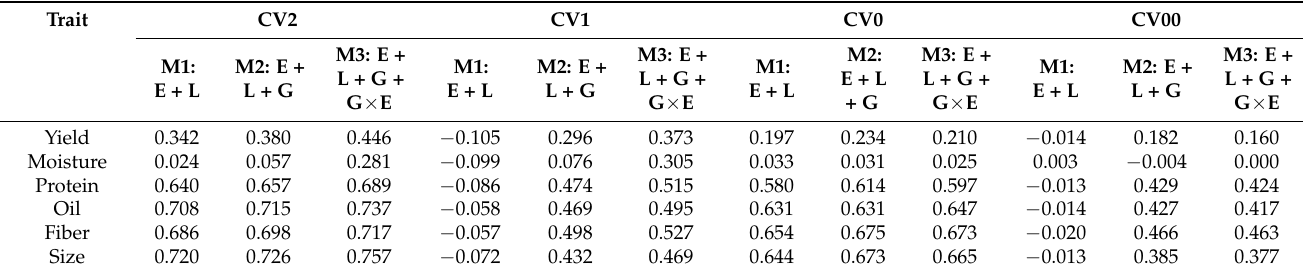
Table 4. Average mean (10 replicates) correlation between predicted and observed values for four cross-validation scenarios, three models (M1: E + L, M2: E + L + G, and M3: E + L + G + G × E) and 6 traits from a sample of the SoyNAM experiment comprised of 324 genotypes observed in 6 environments (all genotypes in all environments).